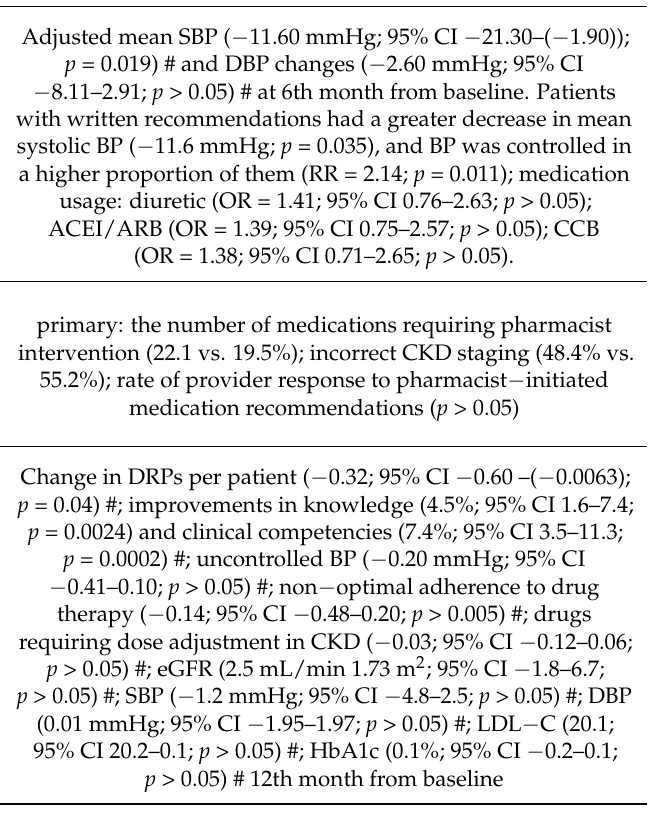
Key Components of Pharmacist Intervention